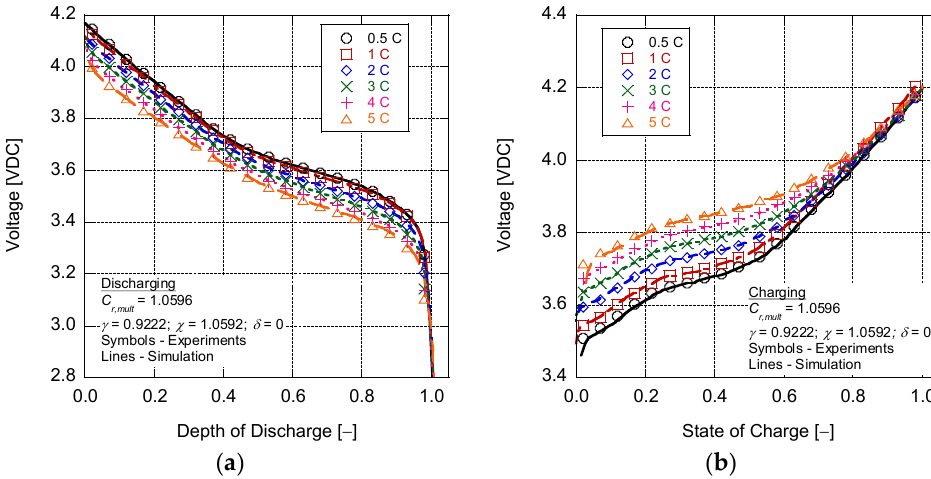
Figure 5. Experimental data and model results of a representative NCM 523 battery during ( a ) discharging and ( b ) charging events.